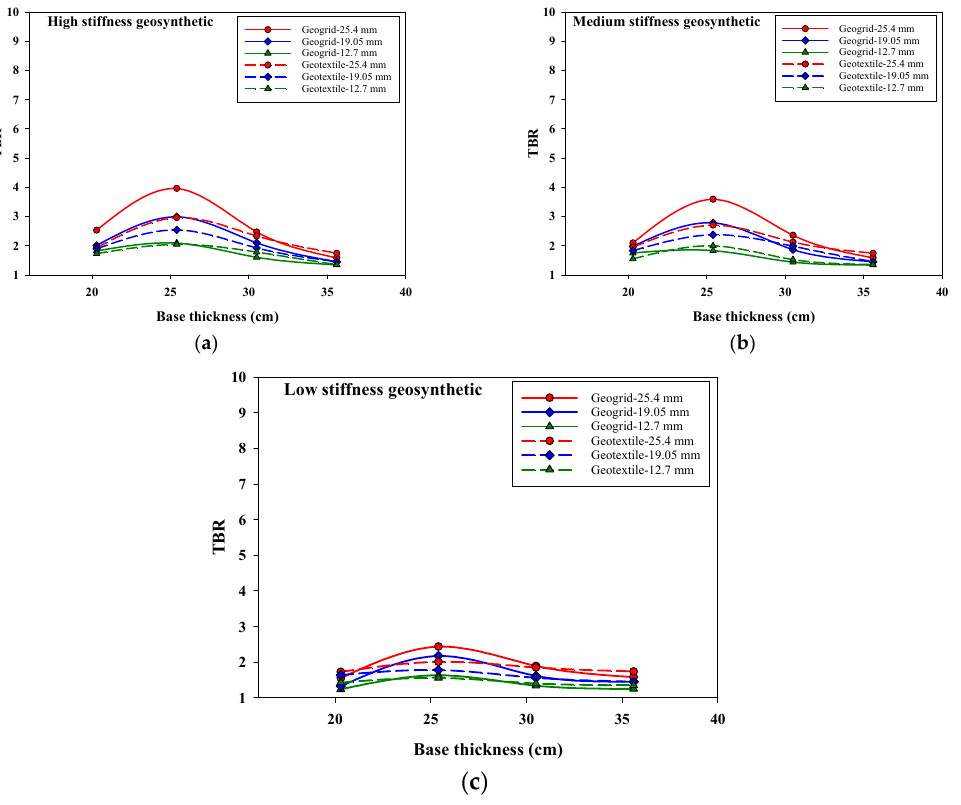
Figure 11. TBR variations with base thickness for pavements reinforced with a single layer of ( a ) high, ( b ) medium, and ( c ) low stiffness geosynthetics on the stiff subgrade.